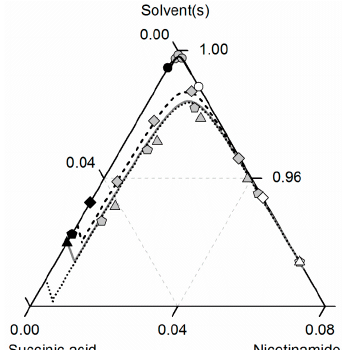
Figure 10. Solubilities of nicotinamide (NA) and succinic acid (SA) and the corresponding 2:1 cocrystal (CC) in ethanol (gray solid lines), ethyl acetate (circles, black solid lines), ethanol/ethyl acetate mixtures in (solute-free) solvent mixtures 0.5/0.5 w / w (triangles, black dotted lines) and 0.25/0.75 w / w (diamonds, black dashed lines) at 310.15 K with shortened axes in mole fractions. Lines correspond to the PC-SAFT predictions; symbols refer to the experimental data points of SA (black), the CC (gray) and NA (white).